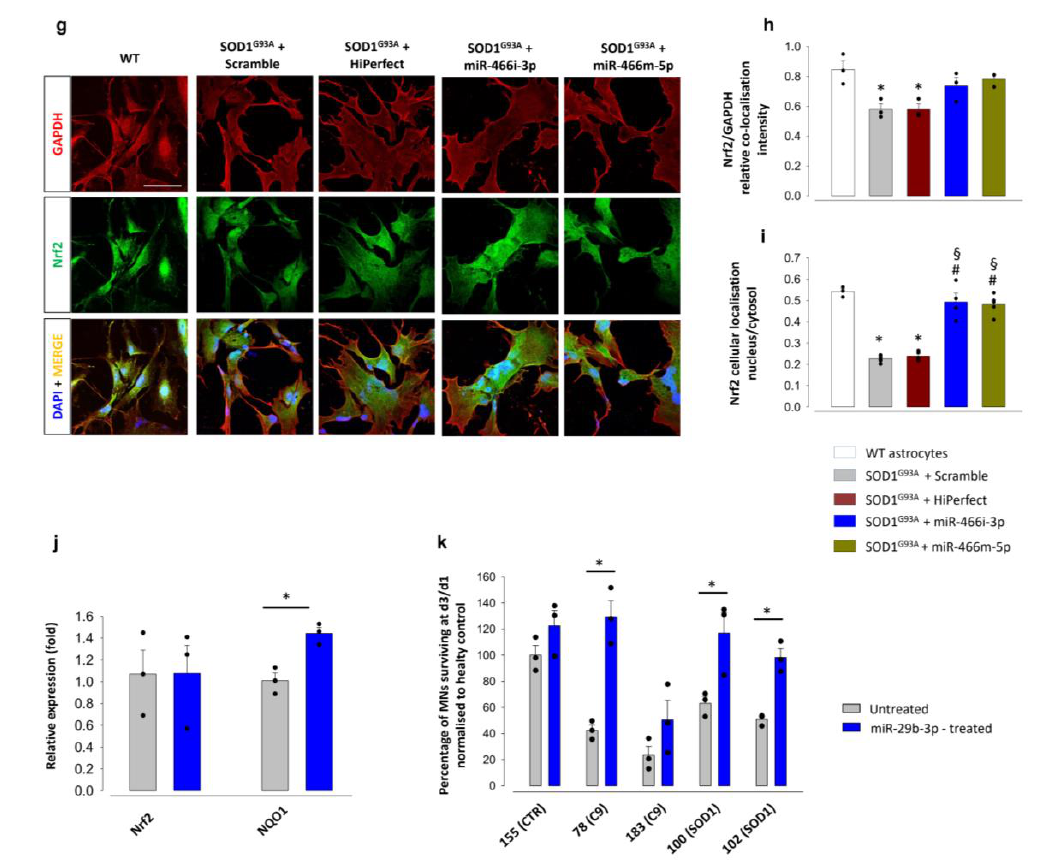
Figure 7. EV-shuttled miRNAs modulate the pathological reactive phenotype, Nrf2 expression, and neurotoxicity in SOD1 G93A astrocytes and iAstrocytes. Graphical representation of ( a ) MAP3K8/MK2, ( b ) MAPK11 and ( f ) Nrf2 pathways. RT-qPCR of ( c ) Map3k8, ( d ) Mapkapk2, and ( e ) Mapk11 expression in WT, SOD1 G93A astrocytes + Hiperfect, SOD1 G93A astrocytes + scrambled miRNAs, and SOD1 G93A astrocytes + miRNAs. Data are presented as means ± SEM of n = 3 independent experiments, run in triplicate; statistical significance for p < 0.05 (* p < 0.05, vs. WT; # p < 0.01 vs. SOD1 G93A astrocytes + Hiperfect; § p < 0.01 vs. SOD1 G93A astrocytes + scrambled miRNA; F (6,14) = 11.738, F (6,14) = 6.321 and F (6,14) = 14.786 for Map3k8, Mapkapk2 and Mapk11, respectively; one-way ANOVA followed by Bonferroni post hoc test). ( g ) Representative images for GAPDH (red fluorescence), Nrf2 (green fluorescence) and DAPI (blue fluorescence), in WT, SOD1 G93A astrocytes, and SOD1 G93A astrocytes treated with miRNAs. Scale bar: 100 µ m. ( h , i ) Quantitative representation of fluorescence intensity (see Figure 2) for ( h ) Nrf2 total expression and ( i ) Nrf2 cellular localization expressed as nuclear/cytoplasm ratio. Data are presented as means ± SEM of n = 3 independent experiments (referred to Nrf2 total expression) and n = 3–6 independent experiments (referred to Nrf2 cellular localization); statistical significance for p < 0.05 (* p < 0.001 vs. WT; # p < 0.001 vs. SOD1 G93A astrocytes + HighPerfect; § p < 0.001 vs. SOD1 G93A astrocytes + scrambled miRNA; Nrf2/GAPDH, F (4,10) = 7.507; Nrf2 nucleus/cytoplasm, F (4,10) = 214,640; two-way ANOVA followed by Bonferroni post hoc test). ( j ) RT-qPCR validation of Nrf2 and NQO1 expression in control iAstrocytes after miR-29b3P transfection. Data are presented as means ± SEM of n = 3 independent experiments; statistical significance for * p < 0.05 vs. control iAstrocytes (NQO1, t = − 4.882; Nrf2, t = − 0.0197; two-tailed Student’s t -test). ( k ) Quantification of MN survival expressed as the percentage of MNs with axon (calculated respect to the total number of MNs at day 1) after 3 days of co-culture with untreated iAstrocytes or iAstrocytes transfected with miRNA mimic miR-29b3P. Data are presented as means ± SEM of n = 3 biological replicates; statistical significance * p < 0.05 vs. untreated iAstrocytes; two-tailed Student’s t